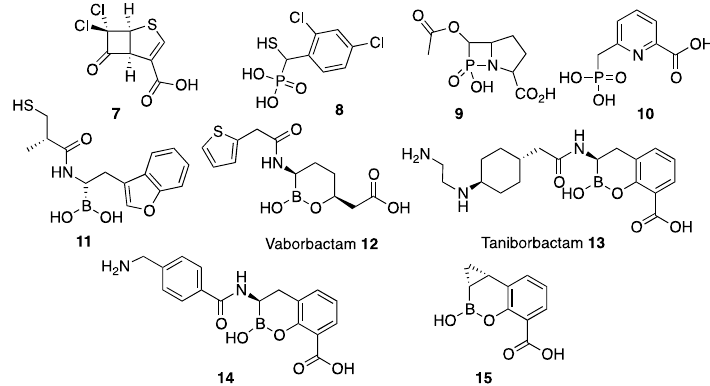
Figure 6. Inhibitors designed as transition state analogues.